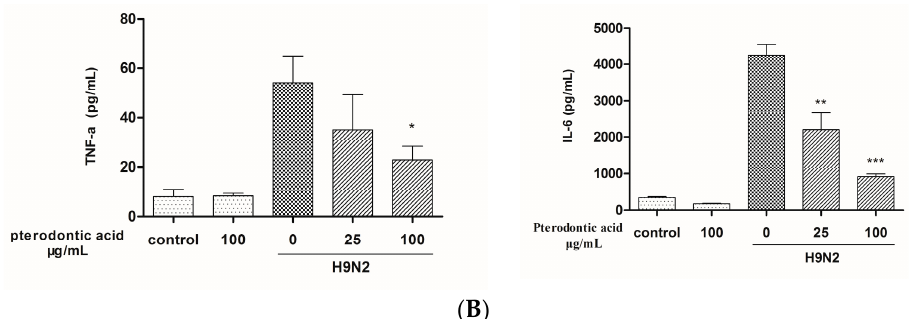
Figure 7. Pterodontic acid inhibited pro-inflammatory expression in influenza virus A/Chicken/Guangdong/1996/ (H9N2)—infected A549 cells. ( A ) A549 cells were infected with influenza virus (MOI = 0.2) in the presence or absence of different concentration of pterodontic acid for 24 h. Then, Total RNA was extracted and measured by qRT-PCR for the expression levels of CCL-5, IP-10, TNF- α , and MIP-1 β . The expression of each target gene was normalized to GAPDH; ( B ) The protein levels of cytokines and chemokines in the culture supernatant were assayed by luminex 24 h post A/Chicken/Guangdong/1996/ (H9N2) infection alone or in combination with pterodontic acid at 25 100 μ g/mL. Each experiment was repeated in triplicate. * p < 0.05, ** p < 0.01, *** p < 0.001, relative to virus control.